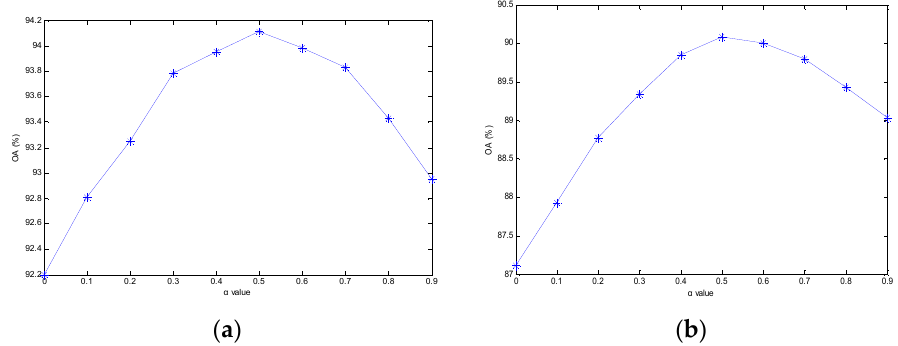
Figure 15. ( a ) OA (%) of SRMSAM-PAN in relation to the weight parameter α in Experiment 2 ( S = 4). ( b ) OA (%) of SRMSAM-PAN in relation to the weight parameter α in Experiment 3 ( S = 4).